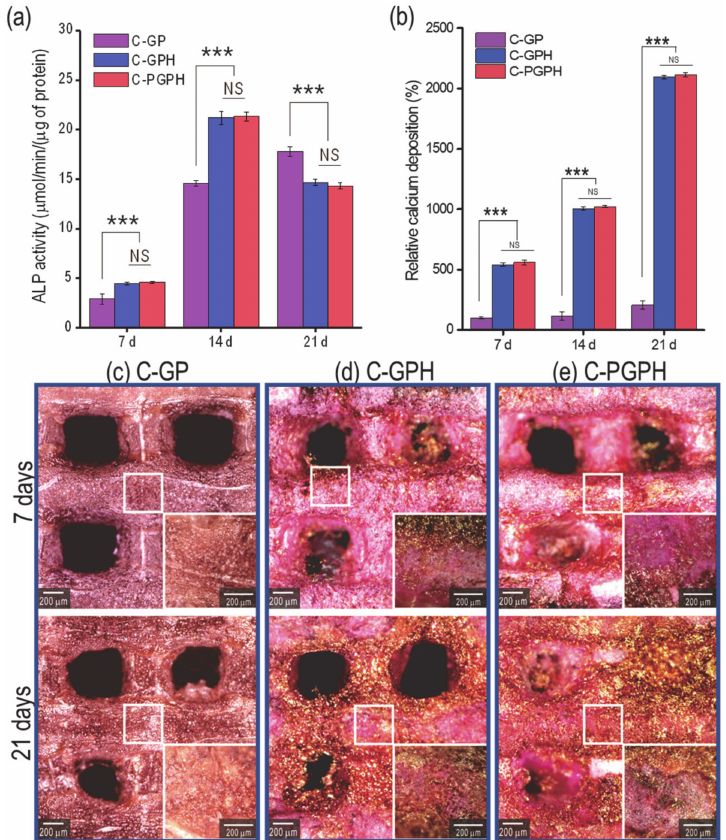
Figure 6. ( a ) Alkaline phosphatase (ALP) activity of cells at 7, 14 and 21 days, ( b ) Relative calcium deposition on sca ff olds at 7, 14 and 21 days of culture and ( c – e ) optical images of sca ff olds stained with alizarin red S. (NS means non-significance and *** p <